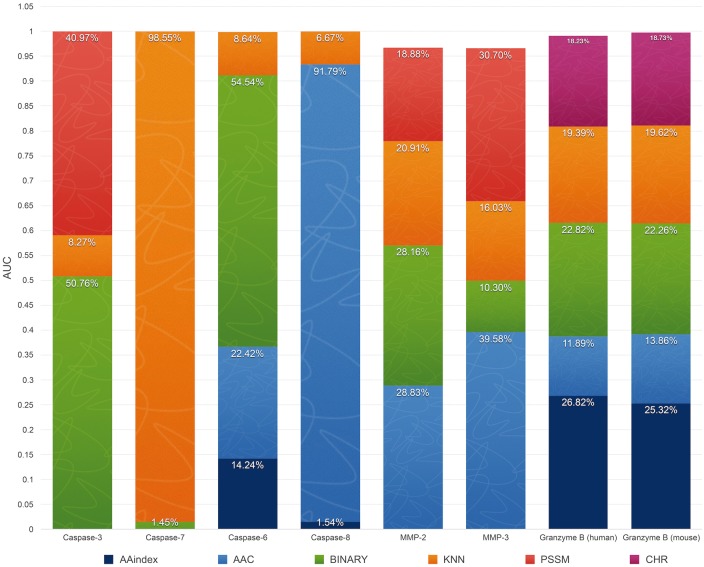
Importance of different feature types to the improvement of cleavage site prediction performance for eight proteases. The height of each bar for a feature type represents the proportional ‘contribution percentage’ that represents the AUC value of the feature selection model for one protease, and the uniformed AUC drop rate for each type of feature is represented with different colors. The AUC drop rate was obtained by comparing with the model after removing this feature from the input.